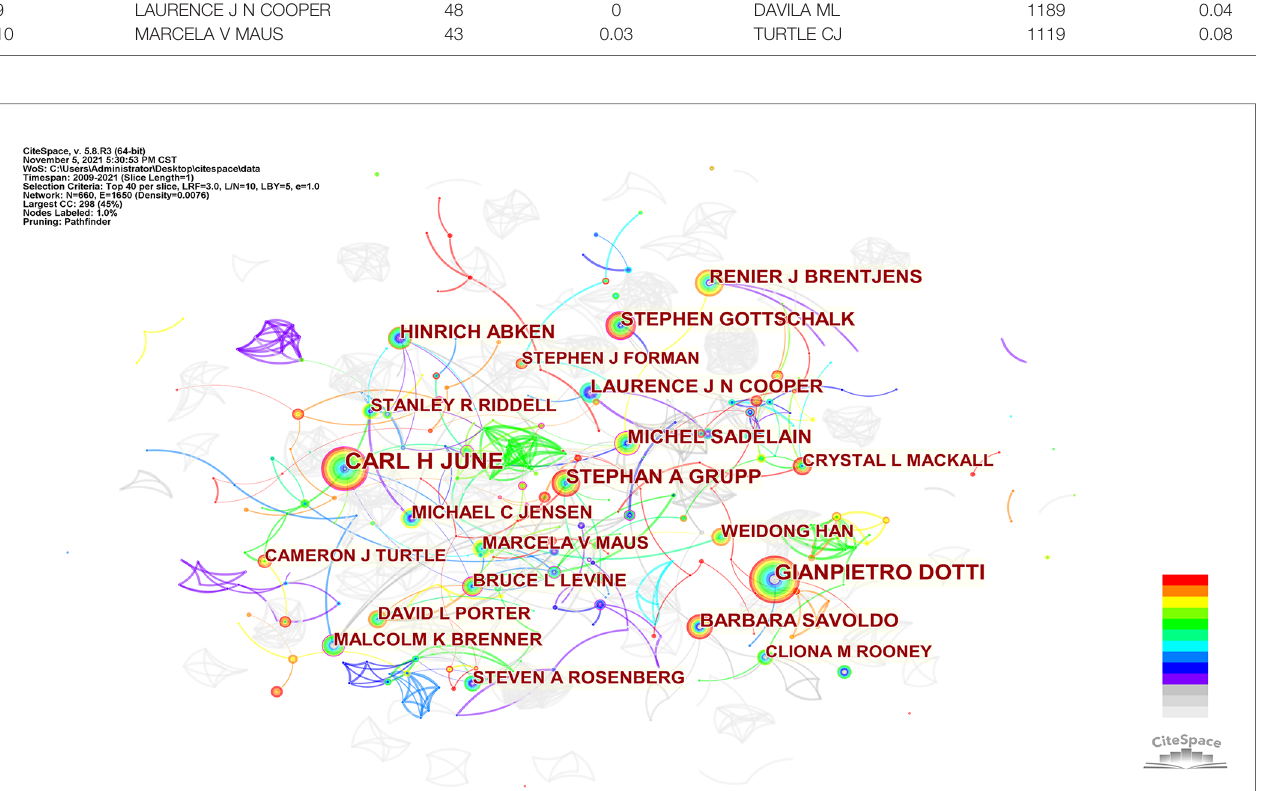
FIGURE 5 | CiteSpace visualization map of authors involved in CAR-T